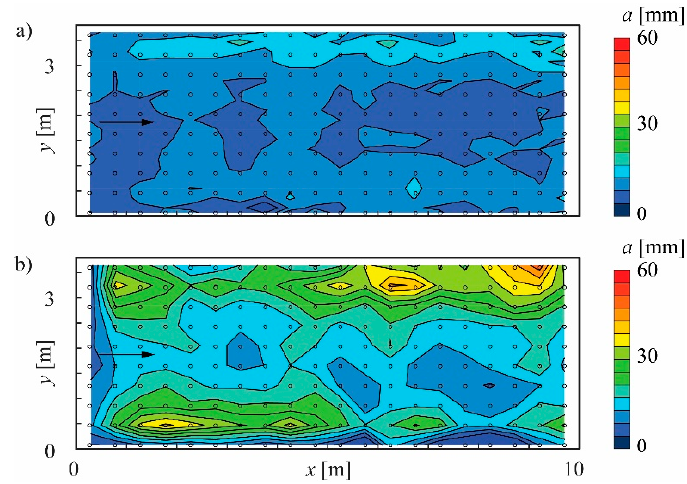
Figure 11. Abrasion depths of the silica fume concrete (SC) test field in Runcahez SBT in ( a ) 1999 after four years of operation and ( b ) 2014 after 19 years of operation (circles represent measurement points).